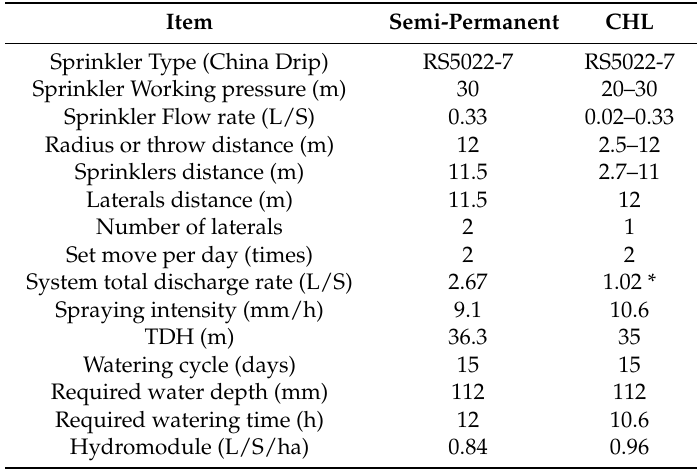
Table 1. Semi-permanent and CHL systems designation parameters.